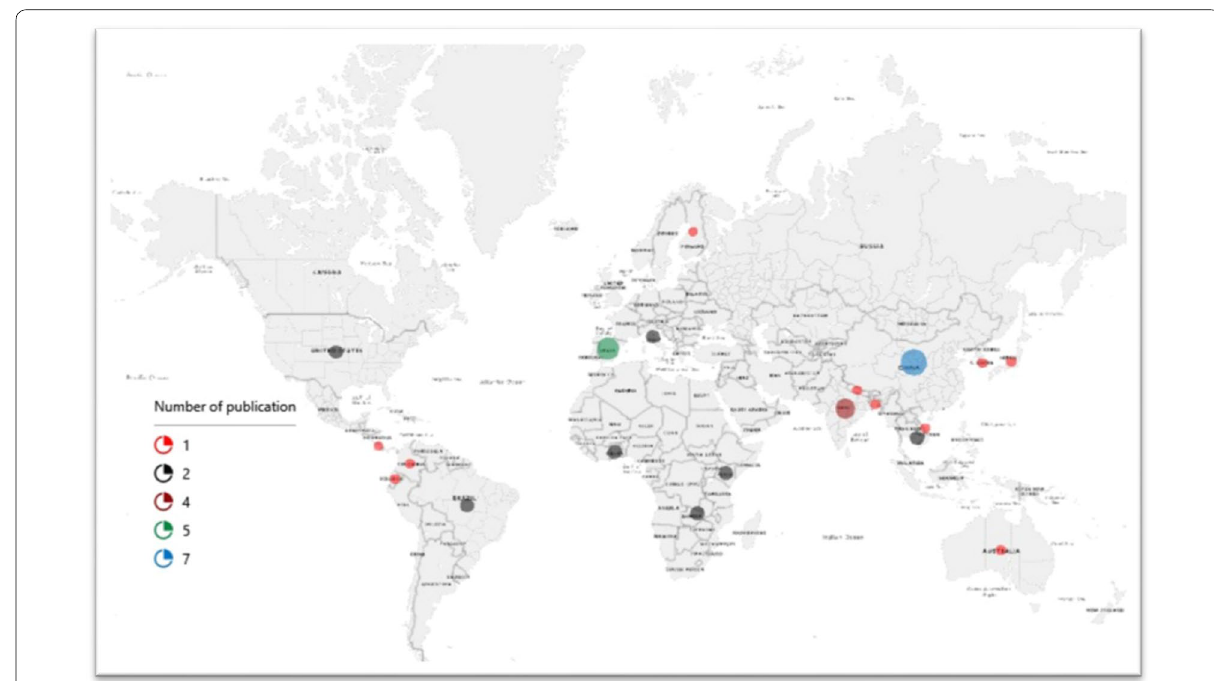
Fig. 6 Distribution map of the FES reviewed publication. The figure was used to show the distribution of the final list of published articles on the world. Most of the articles were conducted in Asia (China and India), Europe (Spain and Italy), and in